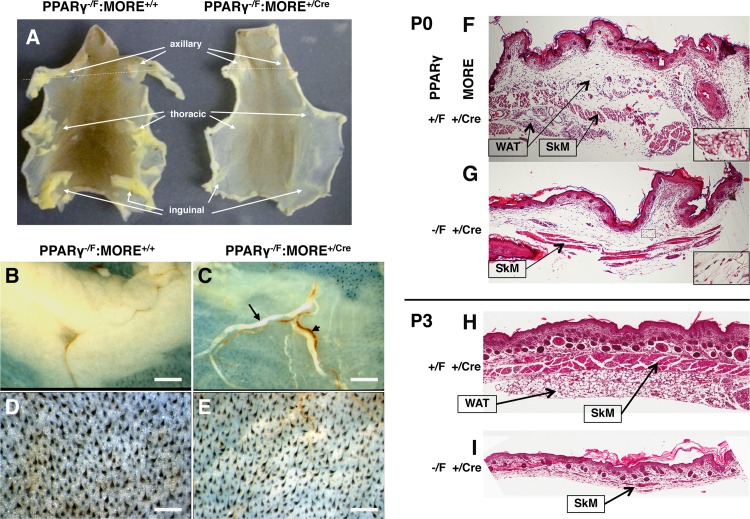
Lipodystrophy in PPARγ-/F:MORE+/Cre neonatal mice.Axillary, inguinal and subcutaneous WAT is significantly diminished and lacks mature adipocytes in PPARγ-/F:MORE+/Cre mice. (A-E) Skin was removed intact from euthanized P3 mice, restrained in a flattened position, fixed in 10% NBF and photographed from the deep aspect. PPARγ-/F:MORE+/Cre mice show greatly diminished axillary, thoracic and inguinal WAT (arrows in A) that contained wispy fibrovascular connective tissue, decreased mature adipocytes, and normal-appearing blood vessels (A, C, E, G, I) in place of well-formed WAT in controls (A, B, D PPARγ-/F:MORE+/+; F, H PPARγ+/F:MORE+/Cre;). Control (D) but not mutant (E) skin also showed refractile collections of subcutaneous adipose tissue that were diffusely distributed both superficial and deep (arrows in F and H) to the panniculus carnosus and were largely lacking in mutant skin (G and I). Dashed lines in A indicate the planes of microtome sectioning used for the histologic images presented in F-I. Long and short arrows in C indicate grossly lipemic and non-lipemic blood, respectively. Dashed rectangles in F and G indicate the areas shown at higher power in the insets. Scale bars: B, C 3 mm; D, E 1 mm.